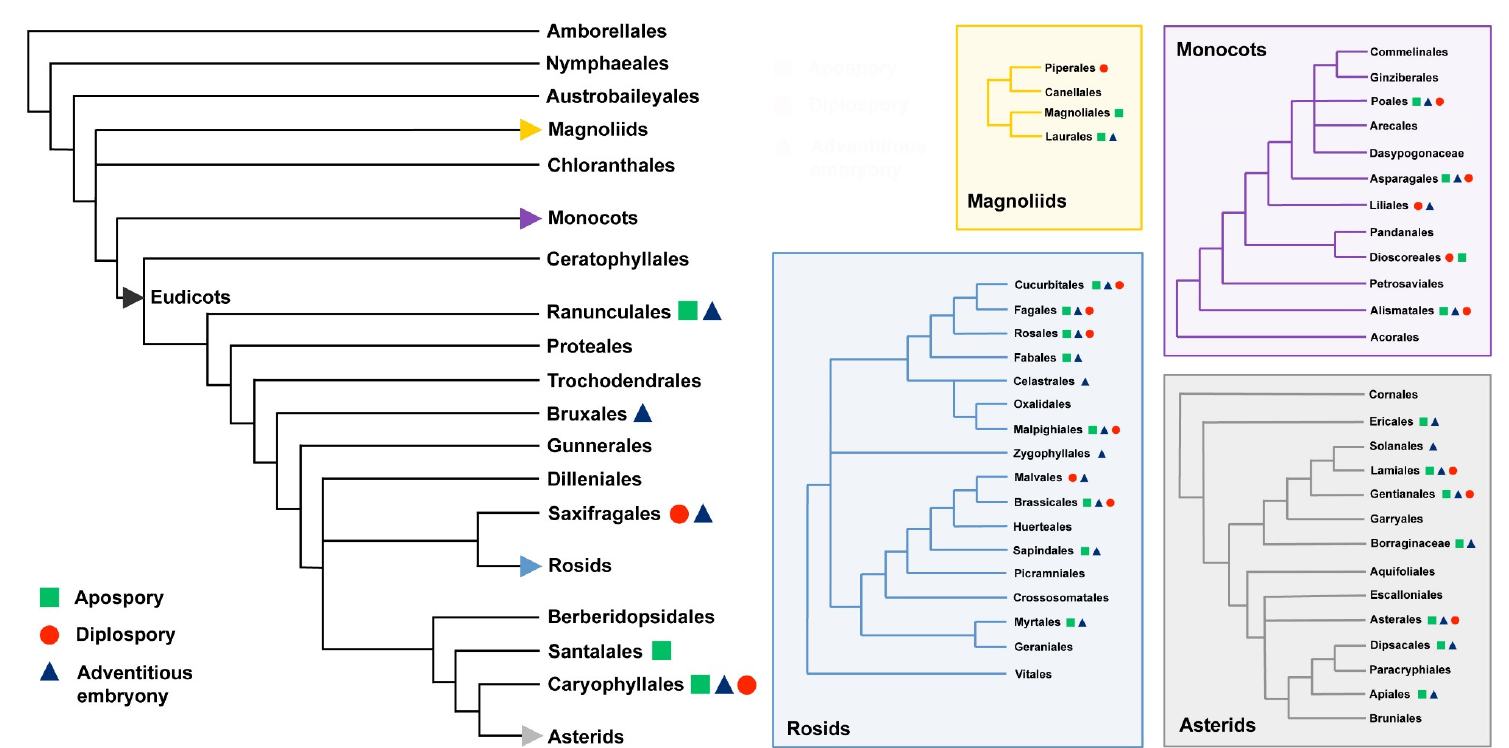
Figure 1. Distribution of the main types of apomixis (i.e., apospory, diplospory and adventitious embryony) among the main clades, orders and families of flowering plants. Detailed information for subclusters belonging to Magnoliids, Monocots, Rosids and Asterids are reported in the coloured boxes. Experimental evidences on apomictic pathways for taxonomic units are derived from [10,29] while phylogenetic trees are modified from [30].